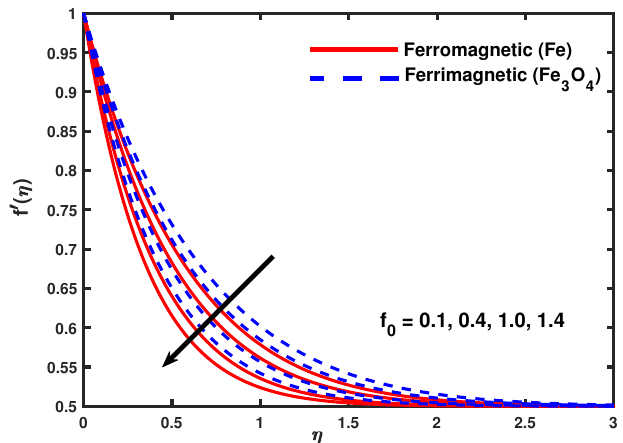
Figure 2. Impact of magnetic nano-particles and suction/injection ( f 0 ) on the velocity profile f (cid:48) ( η ) .